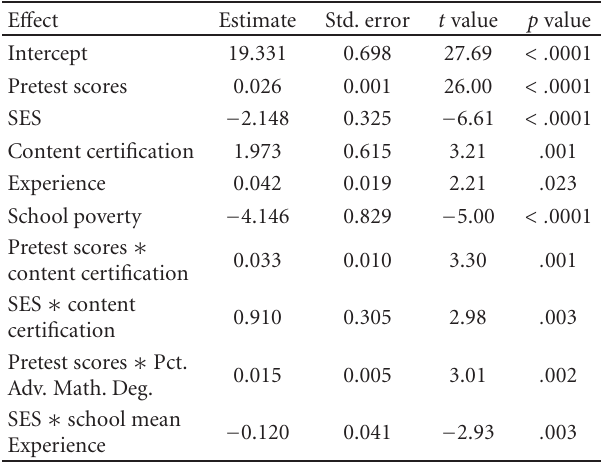
Table 1: Estimated e ff ects of predictors for predicting mathematics gain scores in conditional